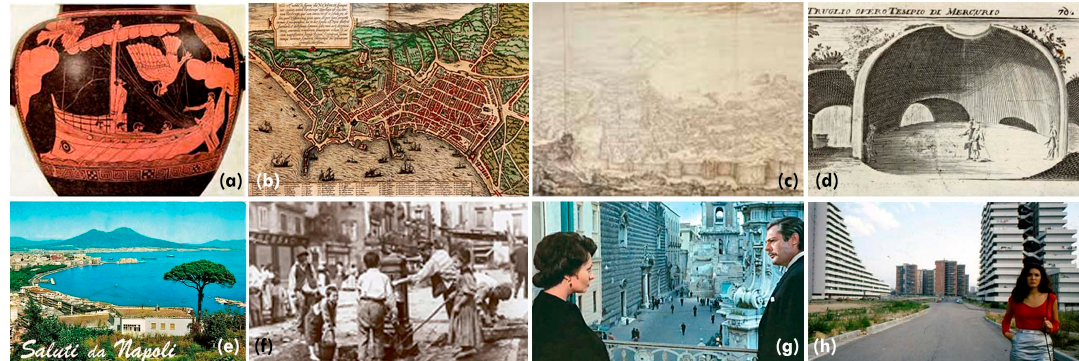
Figure 1. ( a – h ) Naples, city of numerous images: mythological, vedutistic, touristic, social,